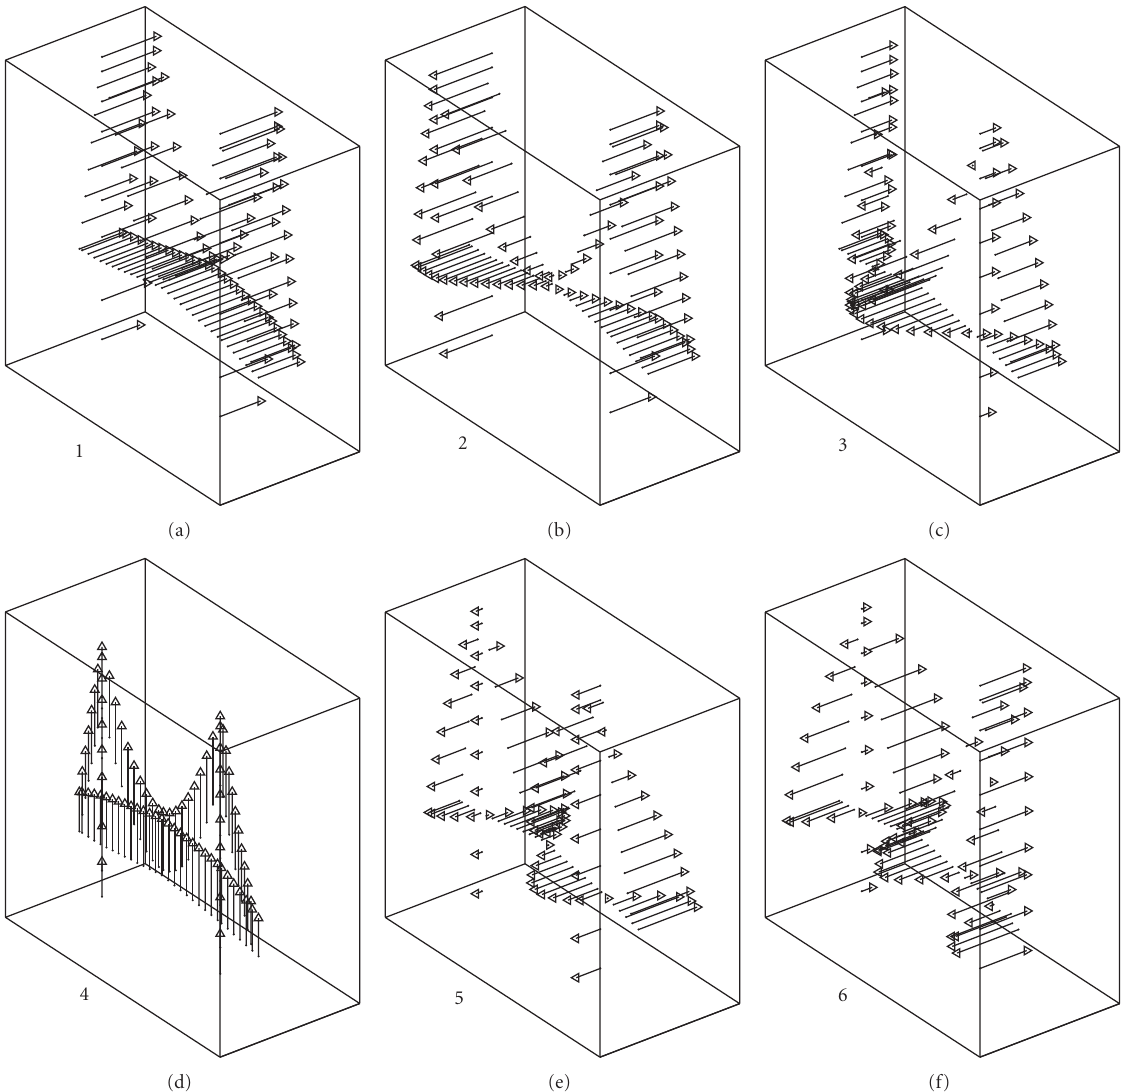
Figure 16: Example 2: first 6 blowing mode shapes evaluated for the circular frequency value ω = 0 . 07